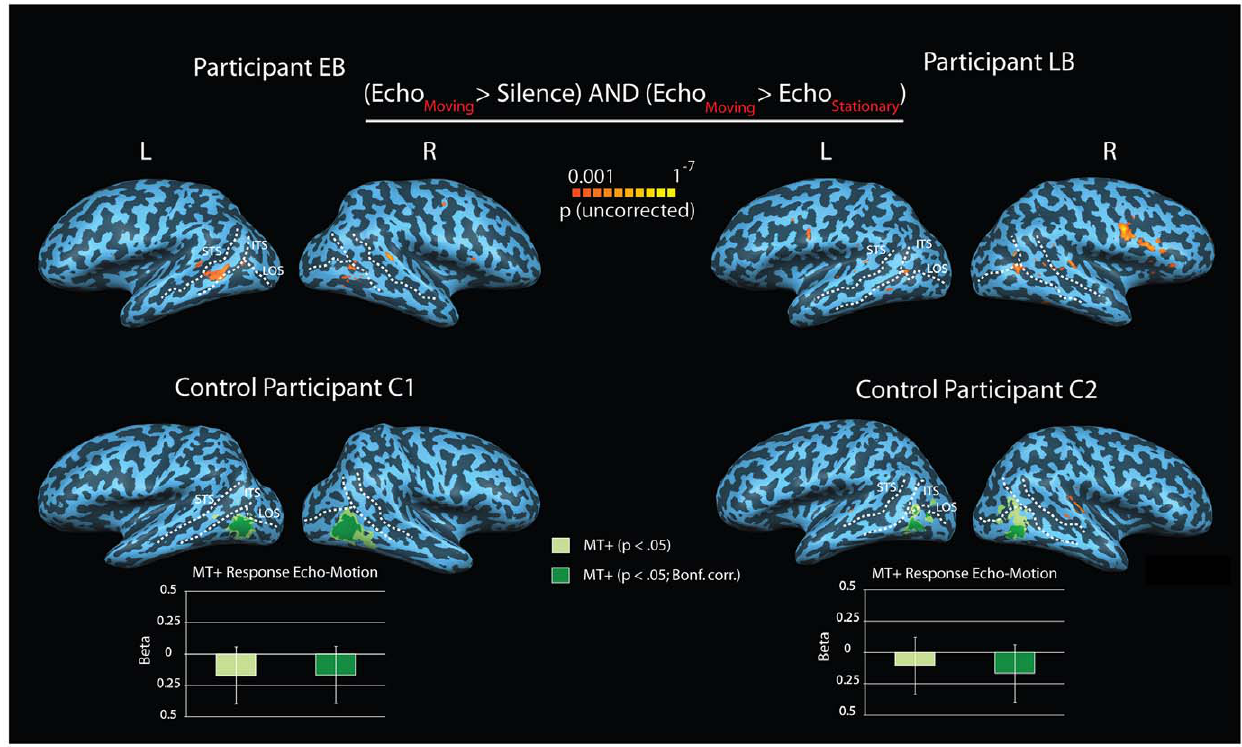
Figure 5. BOLD activity projected on participants reconstructed and partially inflated cortical surface. Concavities and convexities are colored dark and light, respectively. STS-superior temporal sulcus, ITS -inferior temporal sulcus, LOS – lateral occipital sulcus. Top Panel: BOLD activity related to recordings of echolocation sounds conveying movement to EB and LB. Both EB and LB show significant activity in regions adjacent and inferior to the ITS/LOS junction, that are typically involved in motion processing. Bottom Panel: BOLD activity in C1 and C2’s brain related to recordings of echolocation sounds that convey movement to EB and LB. Even though C1 and C2 could reliably classify echolocation sounds as ‘moving’ or ‘stationary’, they reported to not perceive any sense of movement. Also shown are areas sensitive to visual motion (area MT + ) functionally defined at different significance levels (p , .05: light green or p , .05 Bonf. Corrected: dark green). Bar graphs show beta weights ( + / 2 SEM) obtained from a region of interest analysis applied to areas MT + (contrast: Echo Moving . Echo Stationary ). Bar color denotes the MT + used for the ROI analysis (i.e. MT + defined at p , .05: light green, or p , .05; Bonf. Corrected: dark green). In contrast to EB and LB, neither C1 nor C2 show increased BOLD activity in regions adjacent and inferior to the ITS/LOS junction for the contrast between ‘moving’ and ‘stationary’ echolocation stimuli, even at more liberal statistical thresholds (see Figure S4). The statistically more powerful region of interest analysis applied to area MT + was not significant either, i.e. SEM error bars (and therefore any confidence interval) include zero (see also Table